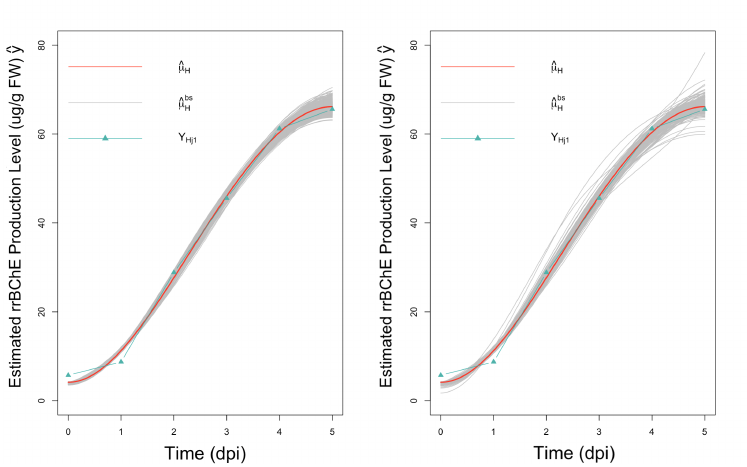
Figure 7. Observations, fitted curves and 500 bootstrap fitted curves for factor H; left : assuming normal noise; and right : assuming t -distributed